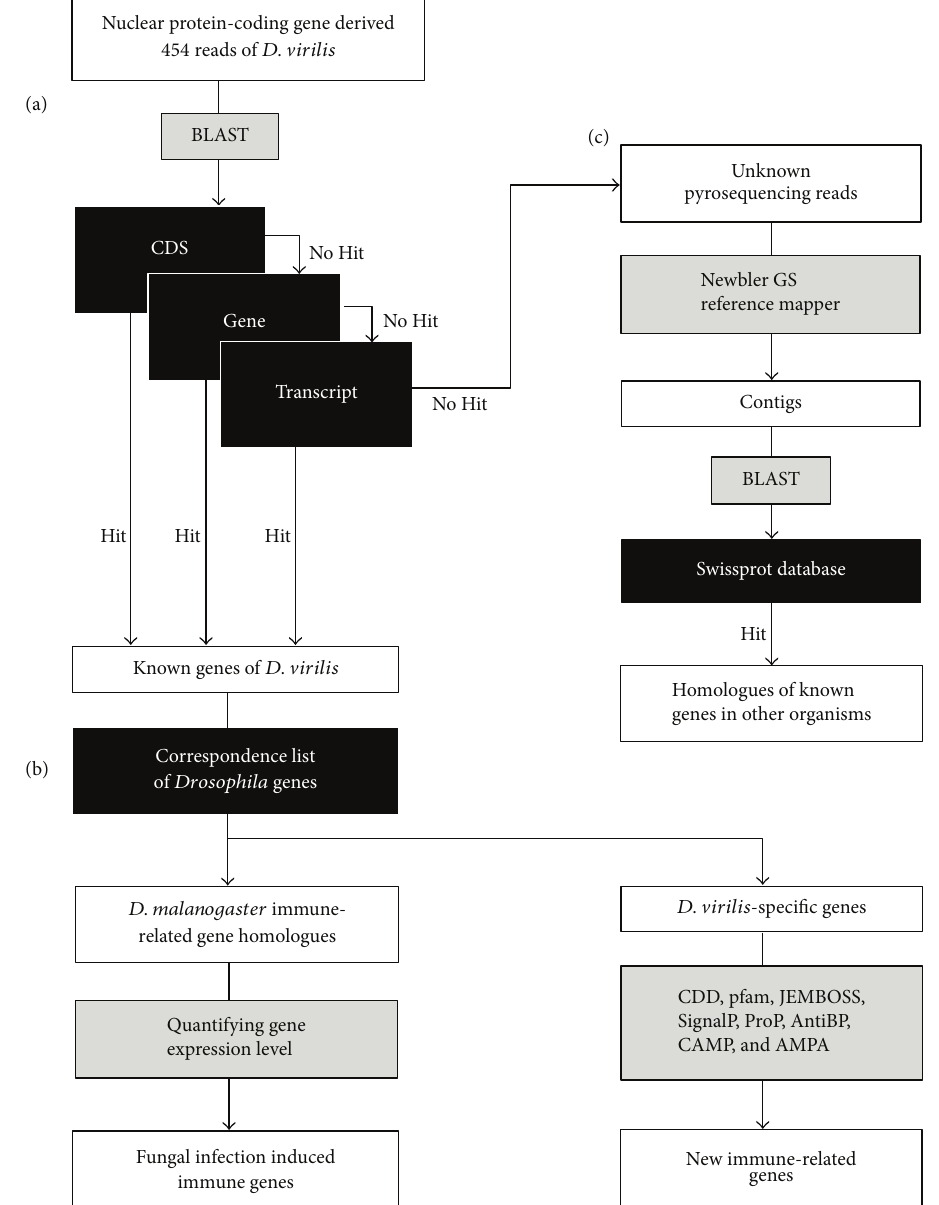
Figure 2: Workflow of data analyses for gene identification (a), gene expression (b), and prediction of immune-related gene (c). Input data in an open box is processed by program(s) in the grey box on the following arrow with or without a database in the black box leading to its outcome in the open